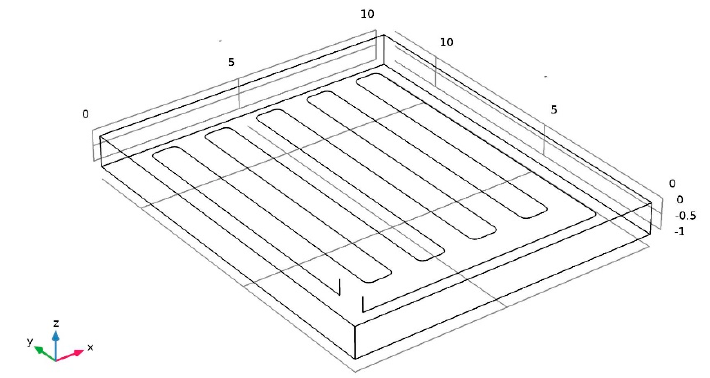
Figure 3. Geometry of the buildings foundation showing the piping system, units in m.